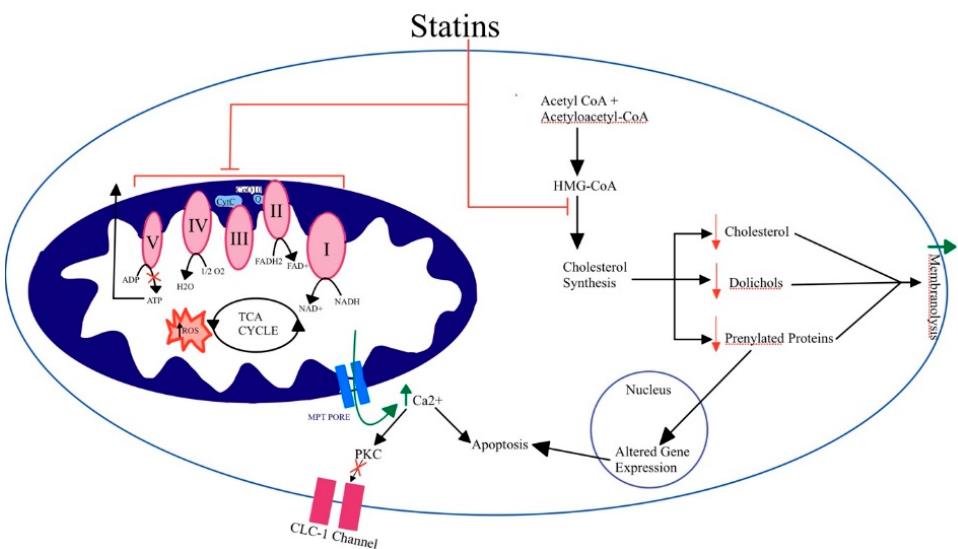
Figure 2. Proposed mechanism for statin-induced myopathy. Impaired calcium signaling increases mitochondrial caspase activity, and apoptosis results in CLC-1 channel inhibition and hyperexcitation of cell membrane ( left of figure). Inhibition of the cholesterol synthesis pathway alters membrane composition, promoting membranolysis ( right of figure). ATP, adenosine triphosphate; CLC-1, chloride channel 1; FAD, flavin adenine dinucleotide; HMG-CoA, β -hydroxy β -methylglutaryl-CoA; MPT pore, mitochondrial permeability transition pore; PKC, protein kinase C; TCA, tricarboxylic acid.